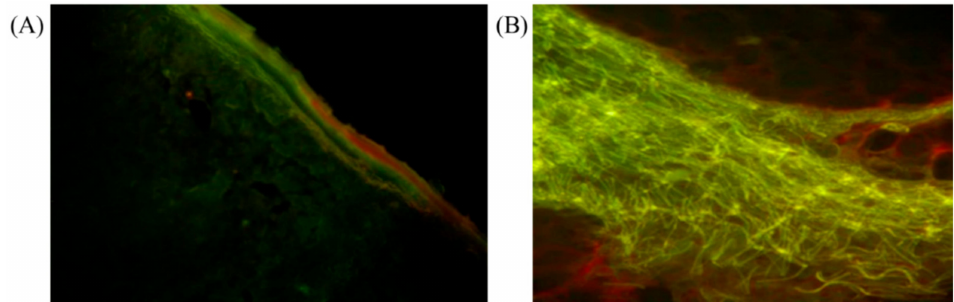
Figure 5. Under a fluorescent microscope, patients who received 633 nm red light illumination have a concomitant increase in fibroblast collagen type I production before ( A ) and after 633 nm LLLT in 6 months ( B